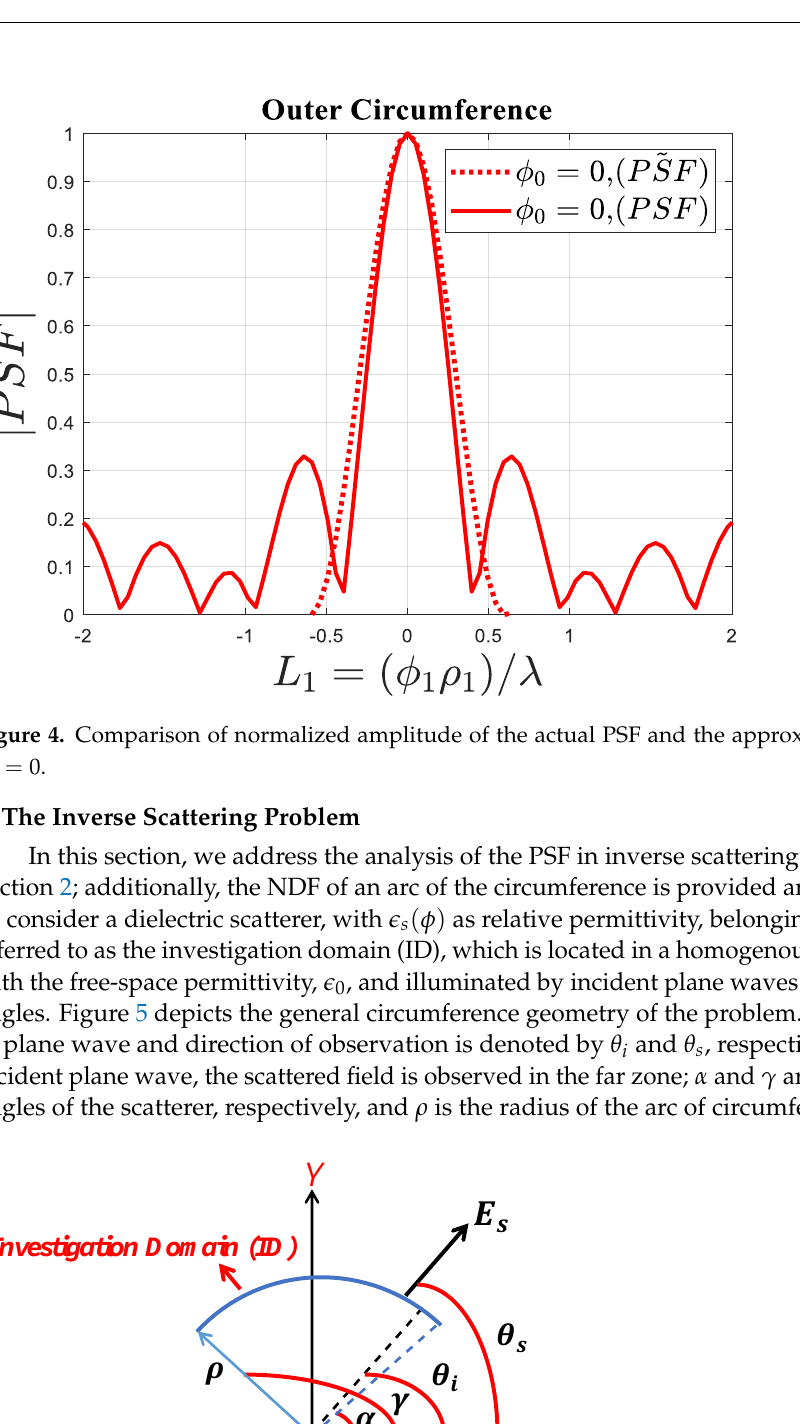
Figure 5. The geometry of the general circumference problem.